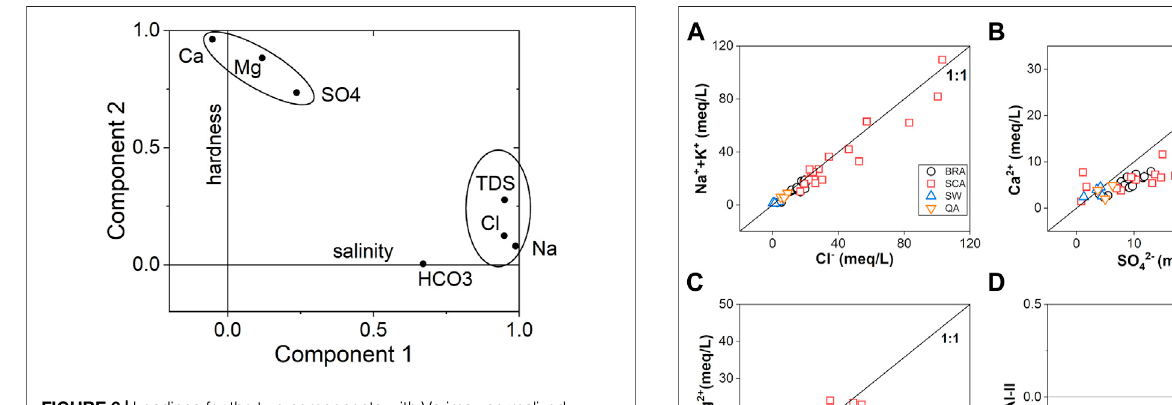
FIGURE 6 | Loadings for the two components with Varimax normalized rotation.